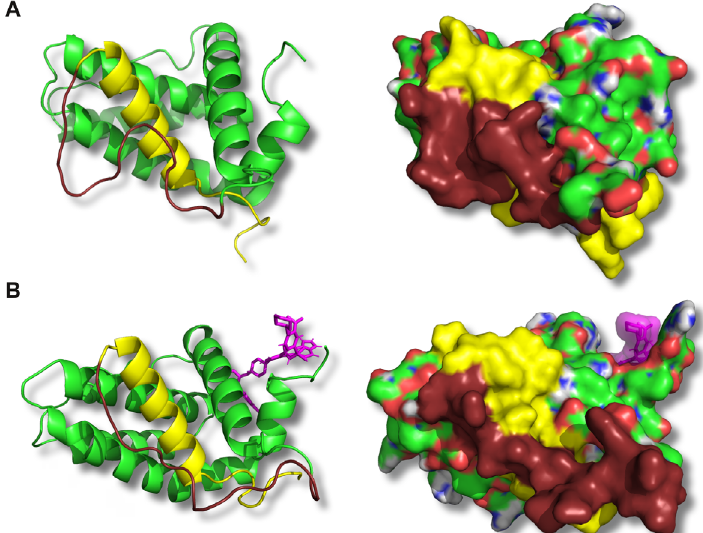
Figure 4. ABT-199 binding to the BH3 hydrophobic cleft leads to conformational changes on the opposite side of Bcl-2 in the BH4 domain. Representative structures corresponding to the medians of principal structure clusters of the free Bcl-2 (A) or Bcl-2:ABT-199 complex (B) following the ABT-199 binding (in B) and equilibration are shown. Panels show a ribbon representation of the backbone (left) or the CPK-colored surface (right) of the Bcl-2 protein. The BH4 domain is highlighted in yellow, and the adjacent loop is in dark brown. ABT-199 is represented with violet sticks (left) or a semitransparent surface (right). Note a difference in BH4 domain structure (both backbone and exposed surface) as well as adhesion of a part of the loop between